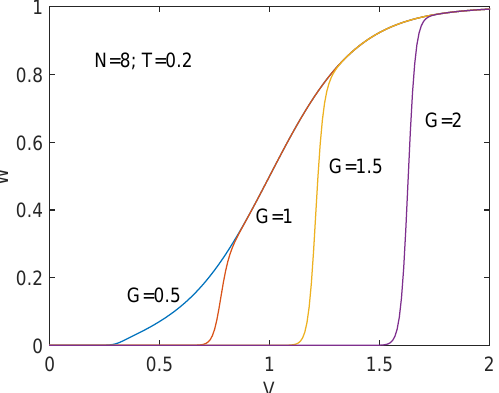
Figure 7. The N dependence. Monopole activity-indicator W versus V for several G values. N = 8 and T = 0.2. Growing pairing works against W